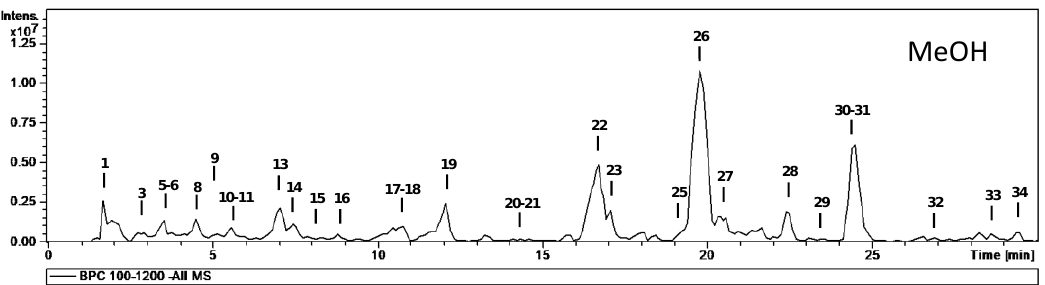
Figure 2. HPLC-ESI-MS n base peak chromatograms of the ethyl acetate extract.